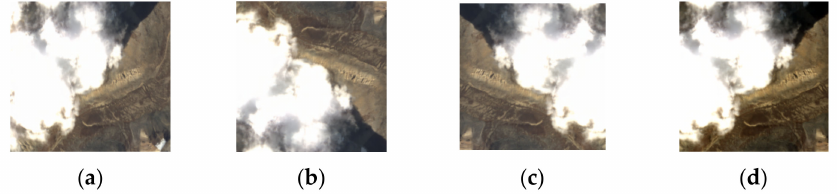
Figure 4. Original and augmented images. ( a ) Original image, ( b ) vertical flip, ( c ) horizontal flip, and ( d ) contrast change.